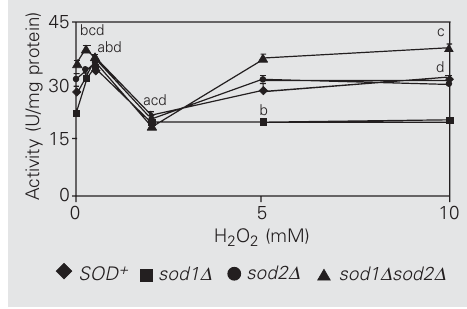
Figure 4. Activity of glutathione peroxidase in wild-type and sod mutant cells exposed to H 2 O 2 . The strains used were: SOD + , sod1 ∆ , sod2 ∆ and sod1 ∆ sod2 ∆ . Data are reported as the mean ± SD of three independent experi- ments. a P < 0.05 compared to SOD + -untreated cells; b P < 0.05 compared to sod1 ∆ -untreated cells; c P < 0.05 compared to sod2 ∆ -untreated cells; d P < 0.05 compared to sod1 ∆ sod2 ∆ - untreated cells (Student t -test).